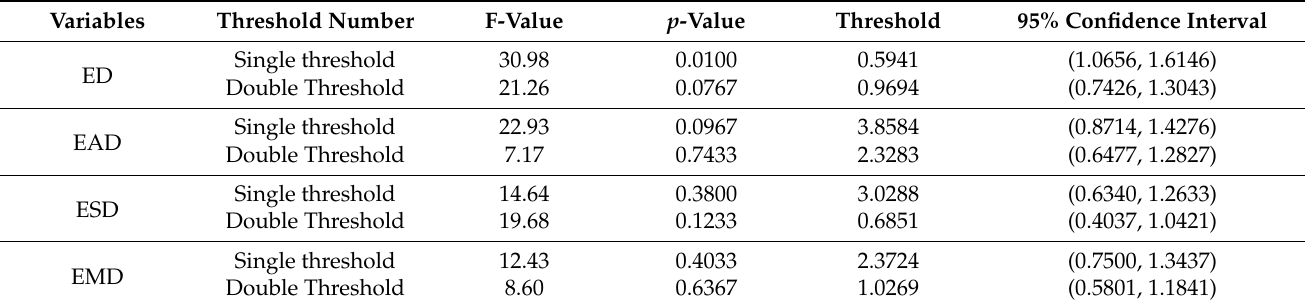
Table 5. Threshold quantity test and threshold estimation.